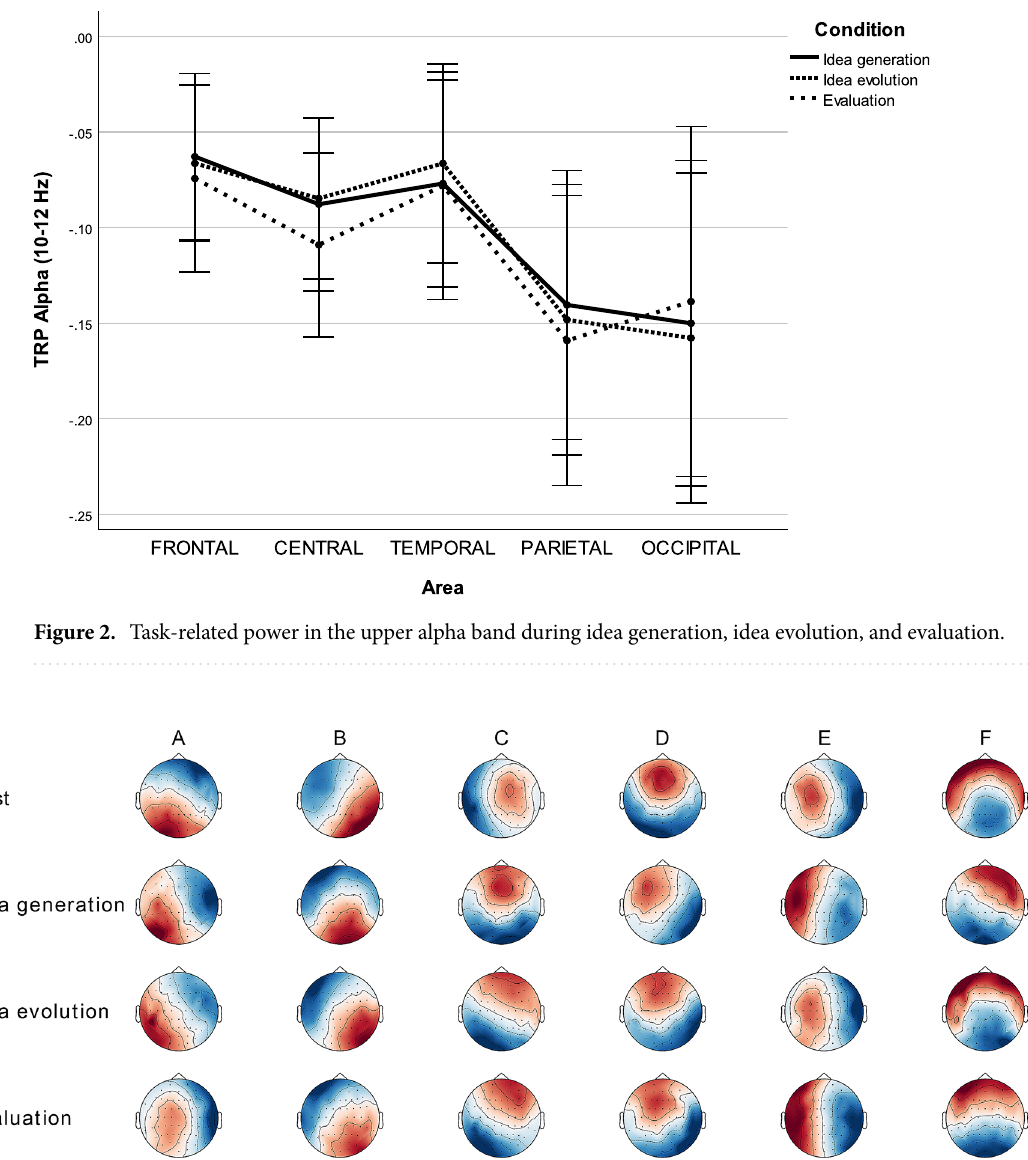
Figure 3. Condition-wise topographies of six microstate classes for the conditions of rest, idea generation, idea evolution, and evaluation. They are labelled and sorted according to Custo et al. 52